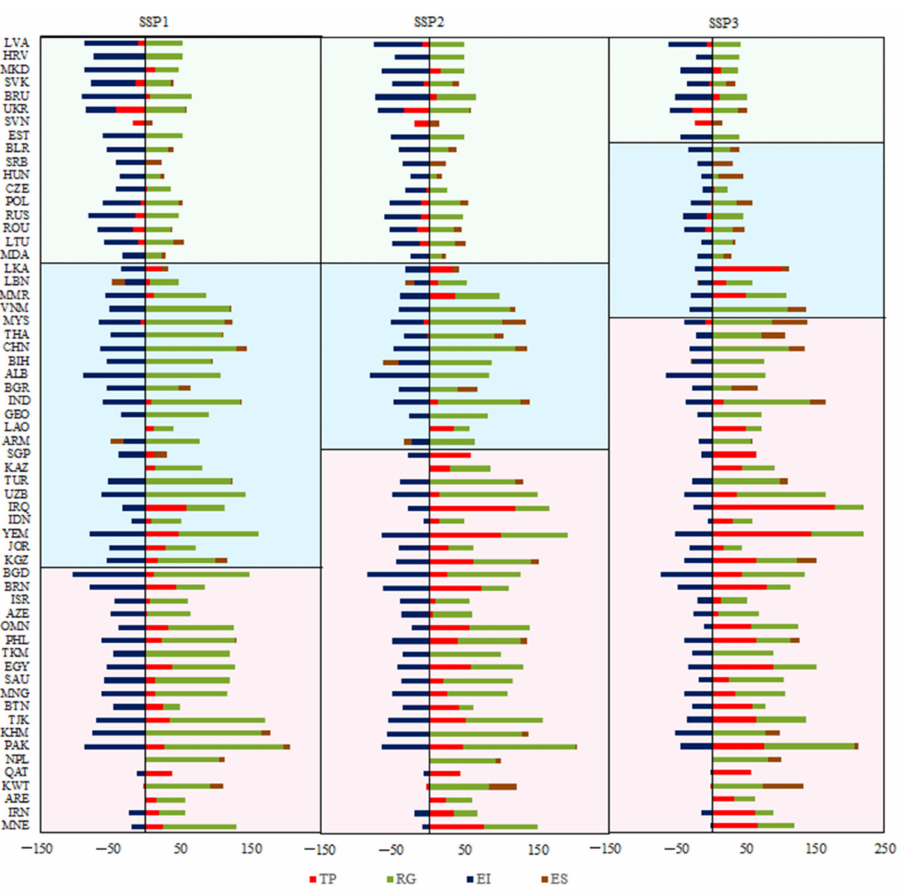
Figure 8. The effects of MDFs in 60 B&R countries. The countries belonging to the decreasing group are marked with a green background, the peaking group is marked with a blue background, and the increasing group is marked with a pink